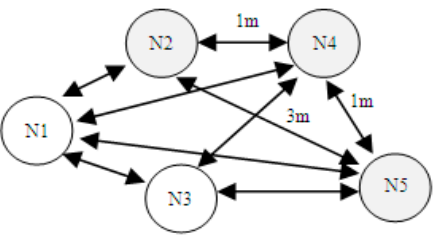
Figure 1. Example of a wireless sensors network with different distances.